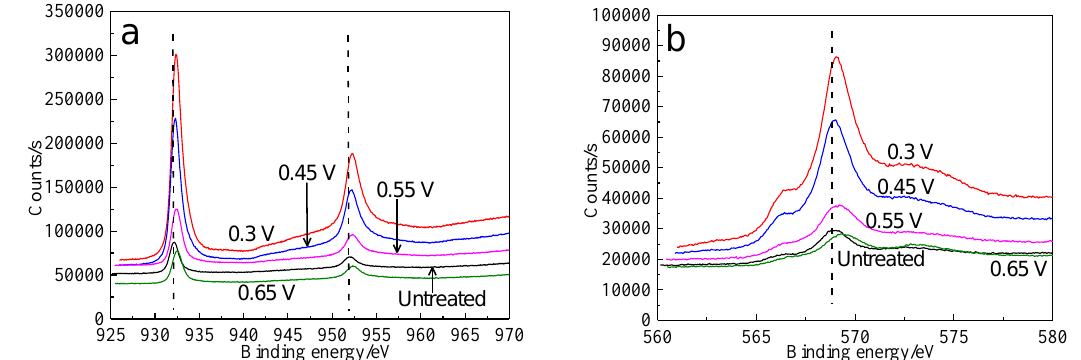
925 930 935 940 945 950 955 960 965 Figure 11. XPS spectra of Cu peaks of bornite surface after treating by different potential of 0, 0.3, 0.45, 0.55, 0.65 V, respectively: ( a ) Cu 2p peak; ( b ) Cu LMM peak (Implemented on the model of ESCALAB 250Xi of Al Kα X-ray source with 20 eV constant pass energy and 0.1 eV/step; Fitted by Thermo Avantage 5.52, C 1s 284.8 eV as reference, Shirley method, Gaussian-Lorentzian function).